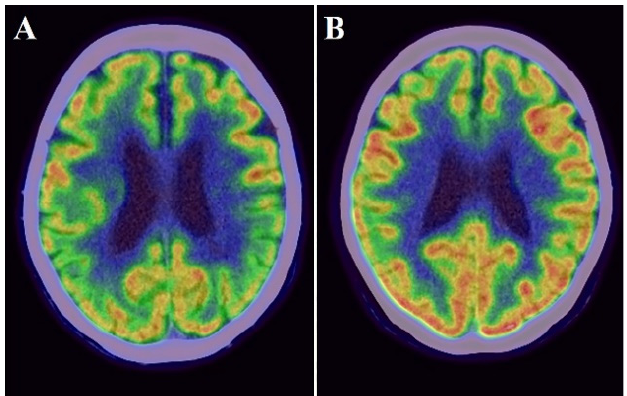
Figure 3. Examples images of an individual with lower FDG uptake ( A : cortical SUVR value = 0.709) and with higher FDG uptake ( B : cortical SUVR value = 0.874).